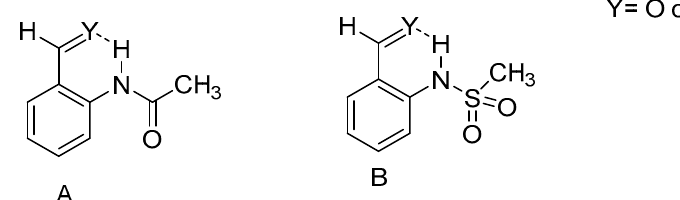
Figure 12. The amino N ‐ oxide demonstrates hydrogen bonding to a charged acceptor. Taken from [42] For the thio ‐ Schiff base resonance forms are demonstrated. Taken from [43]. The number is the NH chemical shift in ppm.